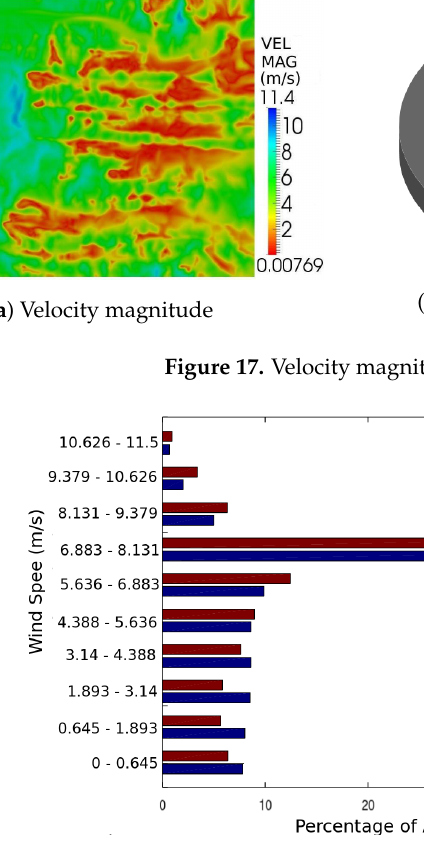
Figure 18. Wind speed’s relative distribution by areas at two elevations.